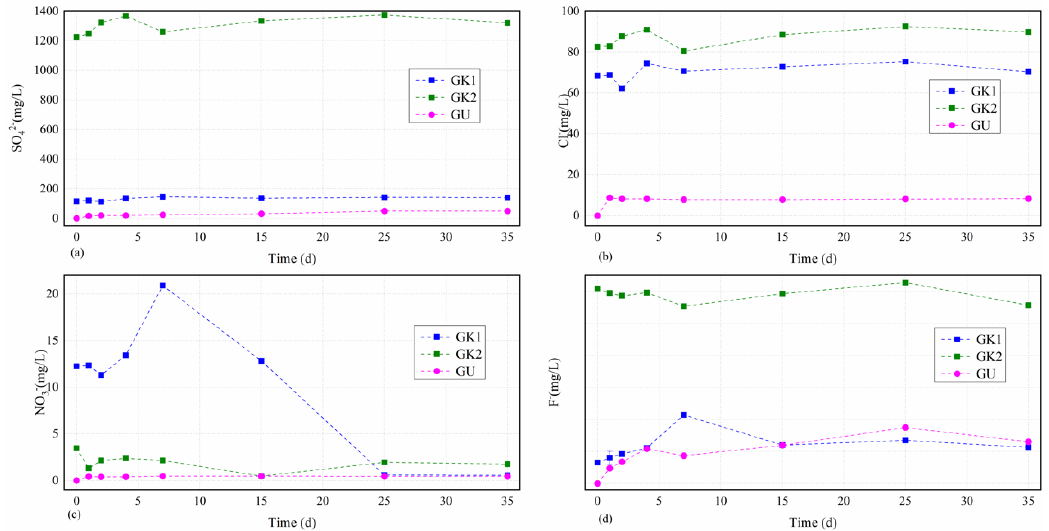
Figure 5. Concentrations’ variation of several anions in different immerse solutions over time. (( a ) Trend plot of Sulfate ions in immersion solution over time; ( b ) Trend plot of Chloride ions in immersion solution over time; ( c ) Trend plot of Nitrate ions in immersion solution over time; ( d ) Trend plot of Fluorine ions in immersion solution over time)